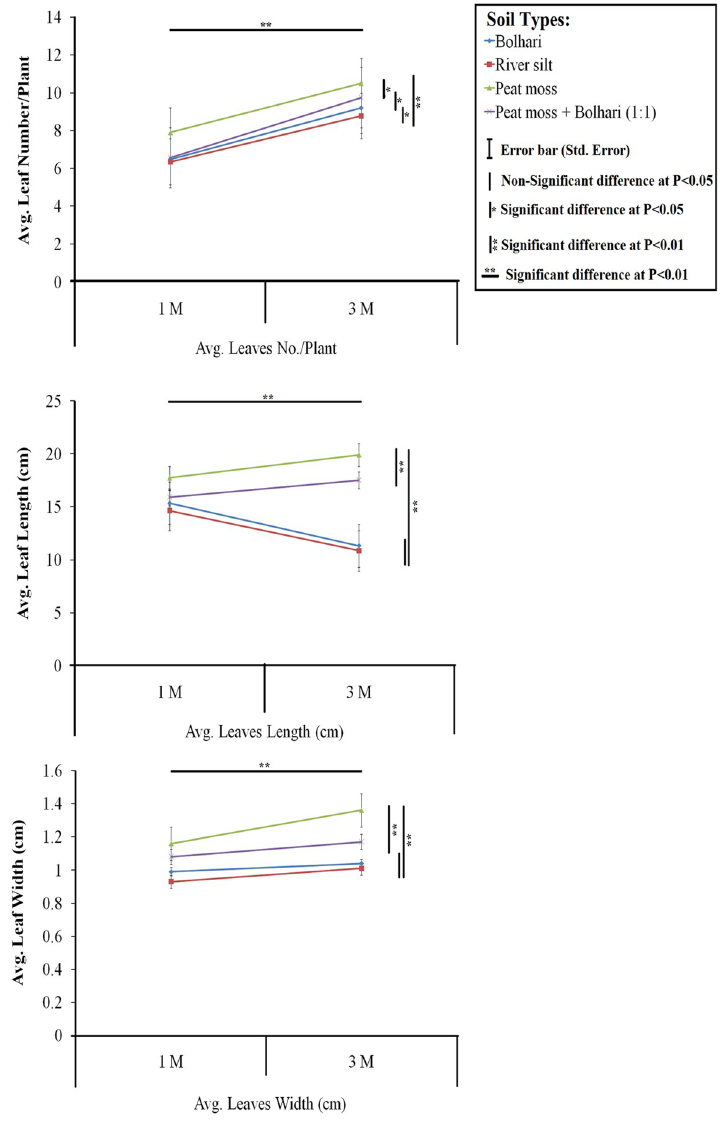
Figure 7. Effect of different soil types on ex vitro shooting of pineapple during